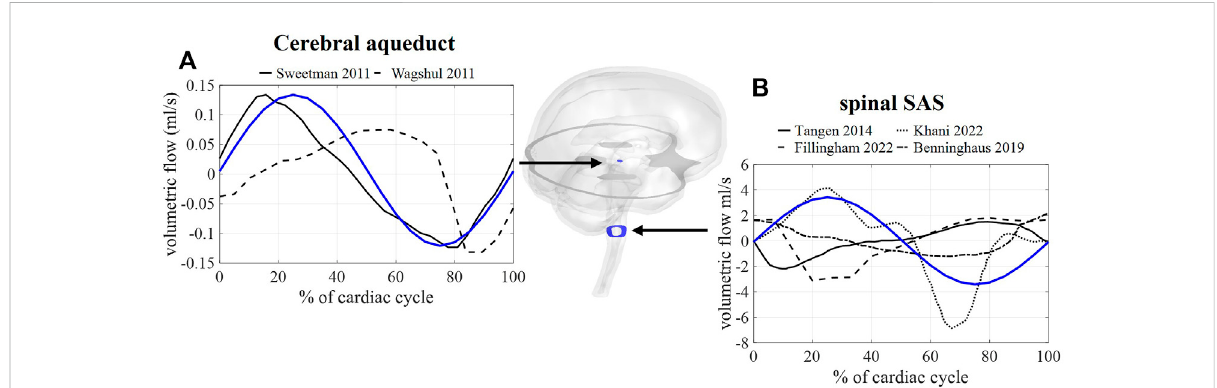
FIGURE 4 CFDsimulationresults (blue)andliteraturemeasurements(black)ofCSF fl owthrough2cross-sections: (A) fl owthroughacross-section ofthe cerebral aqueduct with literature values reported in and reproduced from (Sweetman et al., 2011, Wagshul et al.). (B) Flow through spinal SAS space cross-section with literature values reported in and reproduced from (Tangen et al., 2015; Benninghaus et al., 2019; Fillingham et al., 2022; Khani et al., 2022).